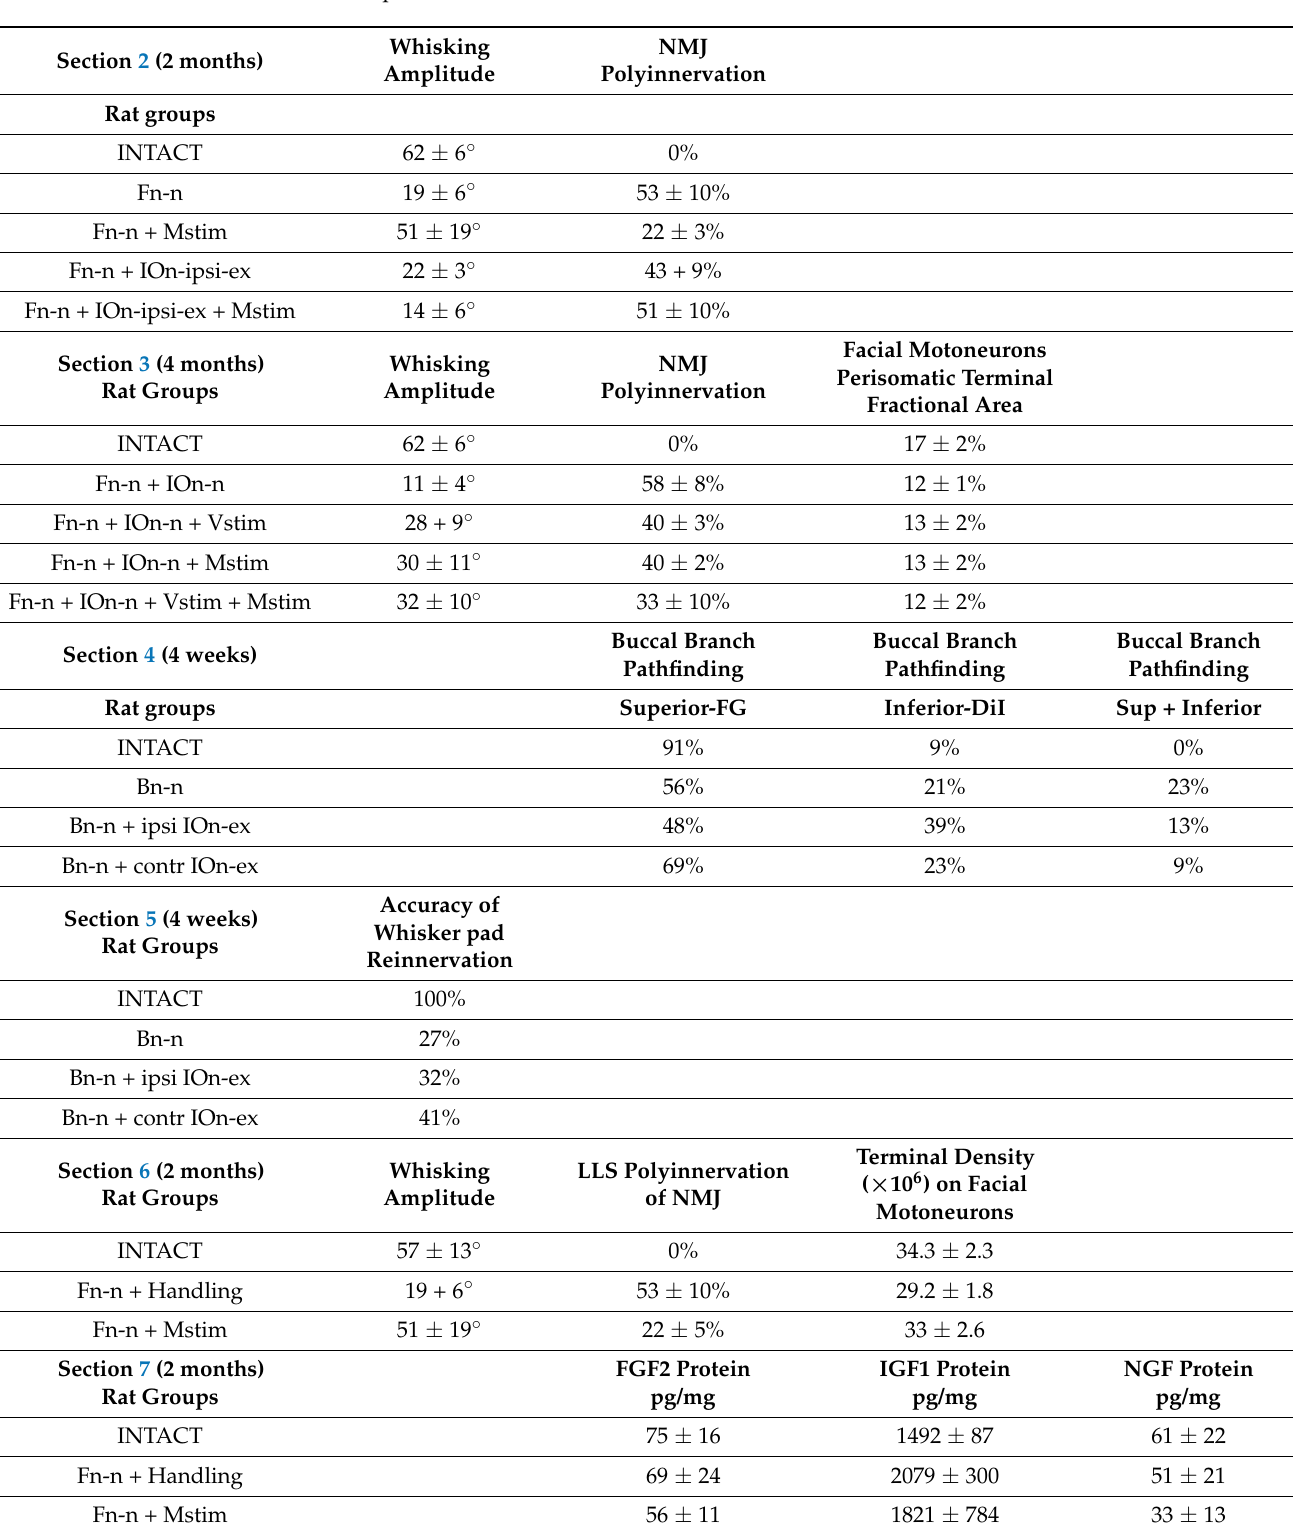
Table 1. Rat control and experimental groups, measurements (means + standard deviations) for experiments and measurements for behavior (whisking amplitude), muscle innervation including polyneuronal innervation, perisynaptic sensory terminal density on motoneurons and neurotrophic factor